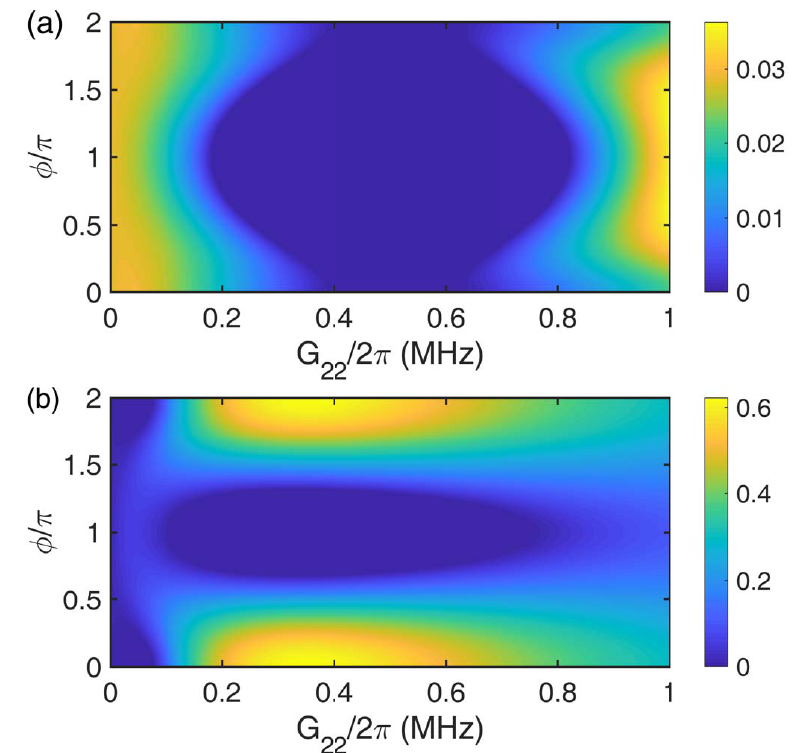
Figure 2. Contour plots of the logarithmic negativity E N between ( a ) the two cavity modes and ( b ) the two mechanical modes as functions of the coupling strength G 22 /2 π and the phase difference φ / π . Parameters are Ω 1 /2 π = 4.34 MHz, Ω 2 /2 π = 5.64 MHz, κ 1 /2 π = 2.42 MHz, κ 2 /2 π = 1.98 MHz, γ 1 /2 π = 40 Hz, γ 2 /2 π = 80 Hz, δ 1 = δ 2 = 0, G 11 /2 π = 0.5 MHz, J 21 = J 12 = 2 π × 0.15 MHz, and T = 20